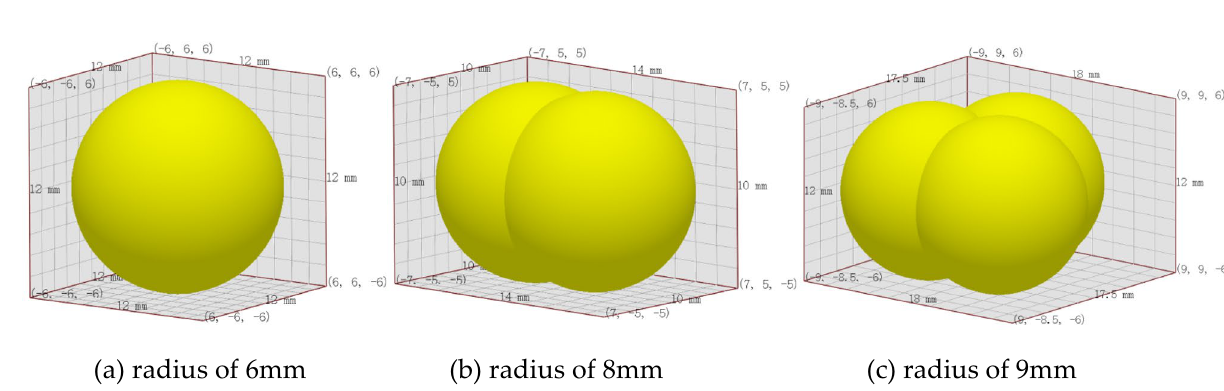
Figure 3. Soil particle